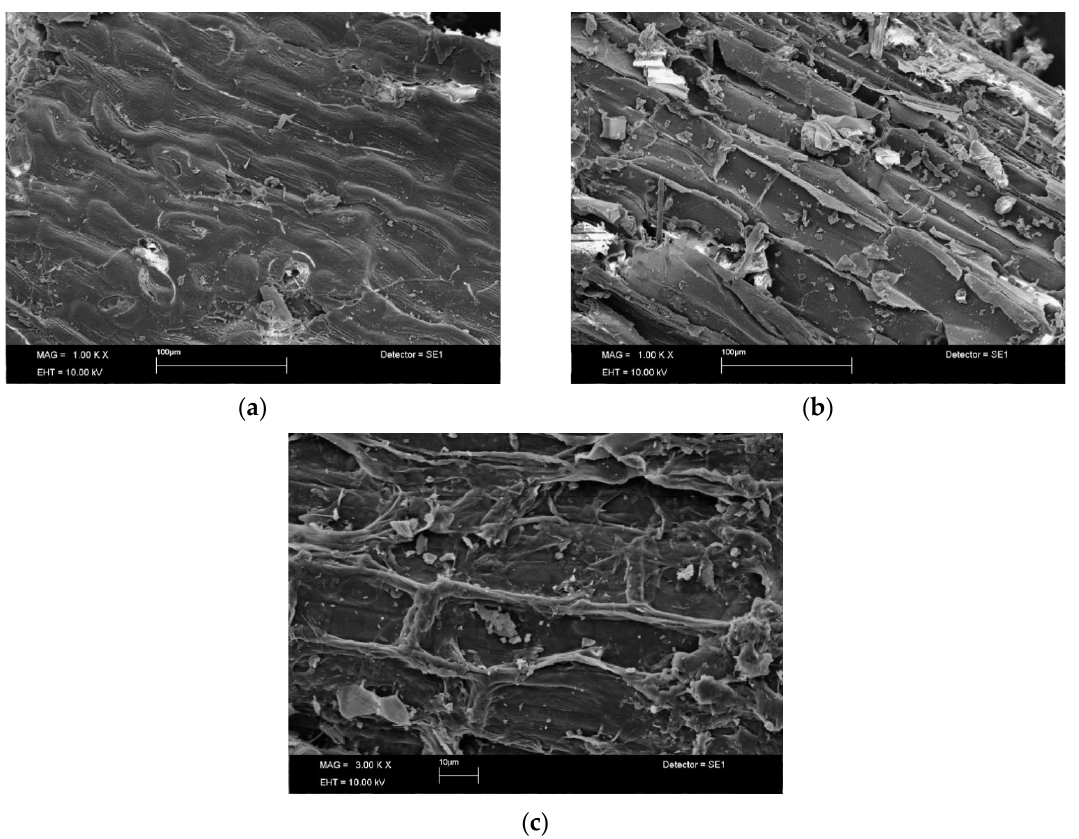
Figure 6. SEM of ( a ) un-ensiled wheat straw; ( b ) co-ensiled wheat straw (from the 80:20, sugar beet root: wheat straw, samples co-ensiled for 6 months); ( c ) wheat straw pre-treated with hydrothermal pre-treatment at 121 °C/1.2 bar for 30 min and chemically pre-treated with tannery wastewater in 24 h at 37 °C.